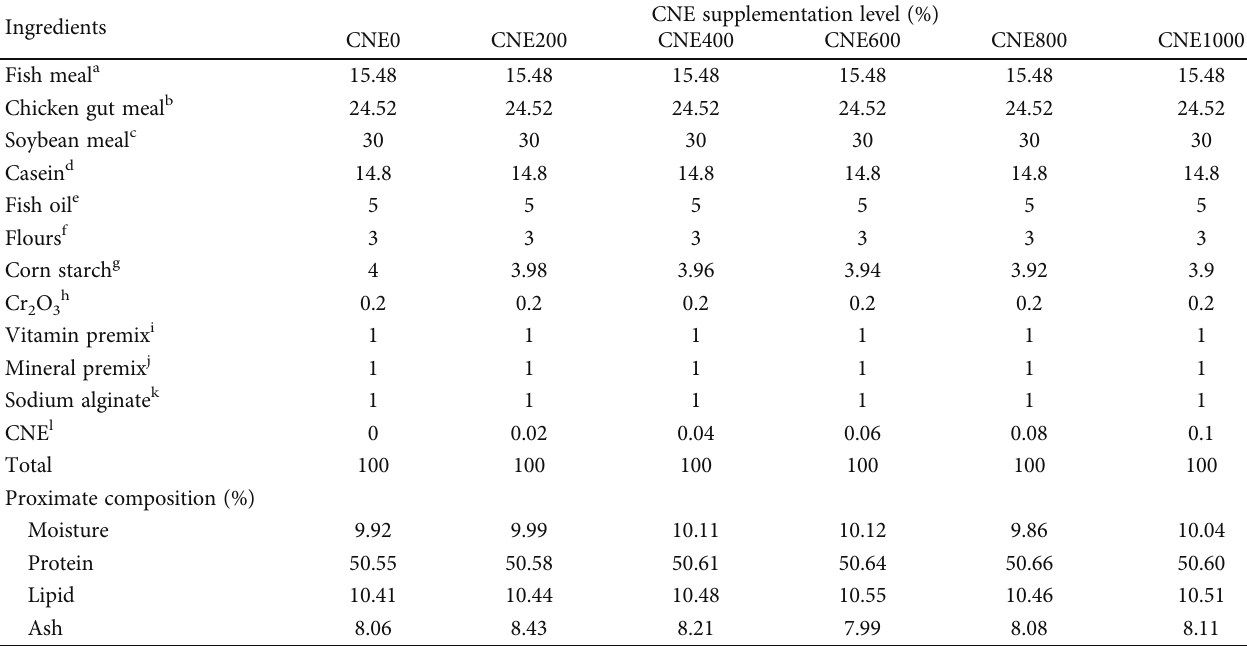
Table 1: Formulation and proximate composition of the experimental diets (% dry matter).